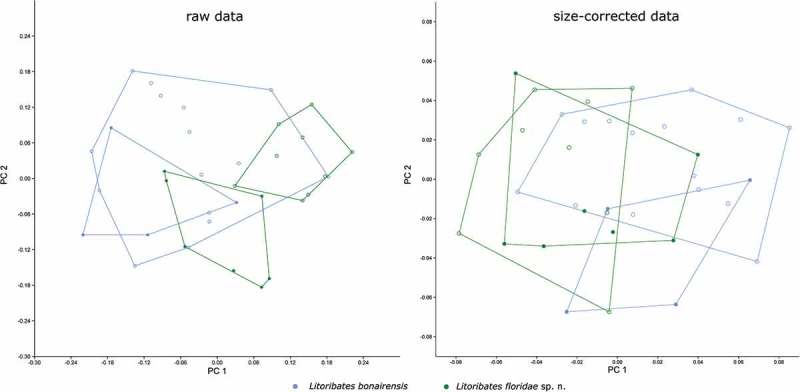
Scatter plots of PCA of L. bonairensis from Bonaire and L. floridae sp. nov. from Florida. Open symbols refer to females; filled symbols refer to male specimens. For better display of sexual dimorphism, each gender is given in a separate hull.